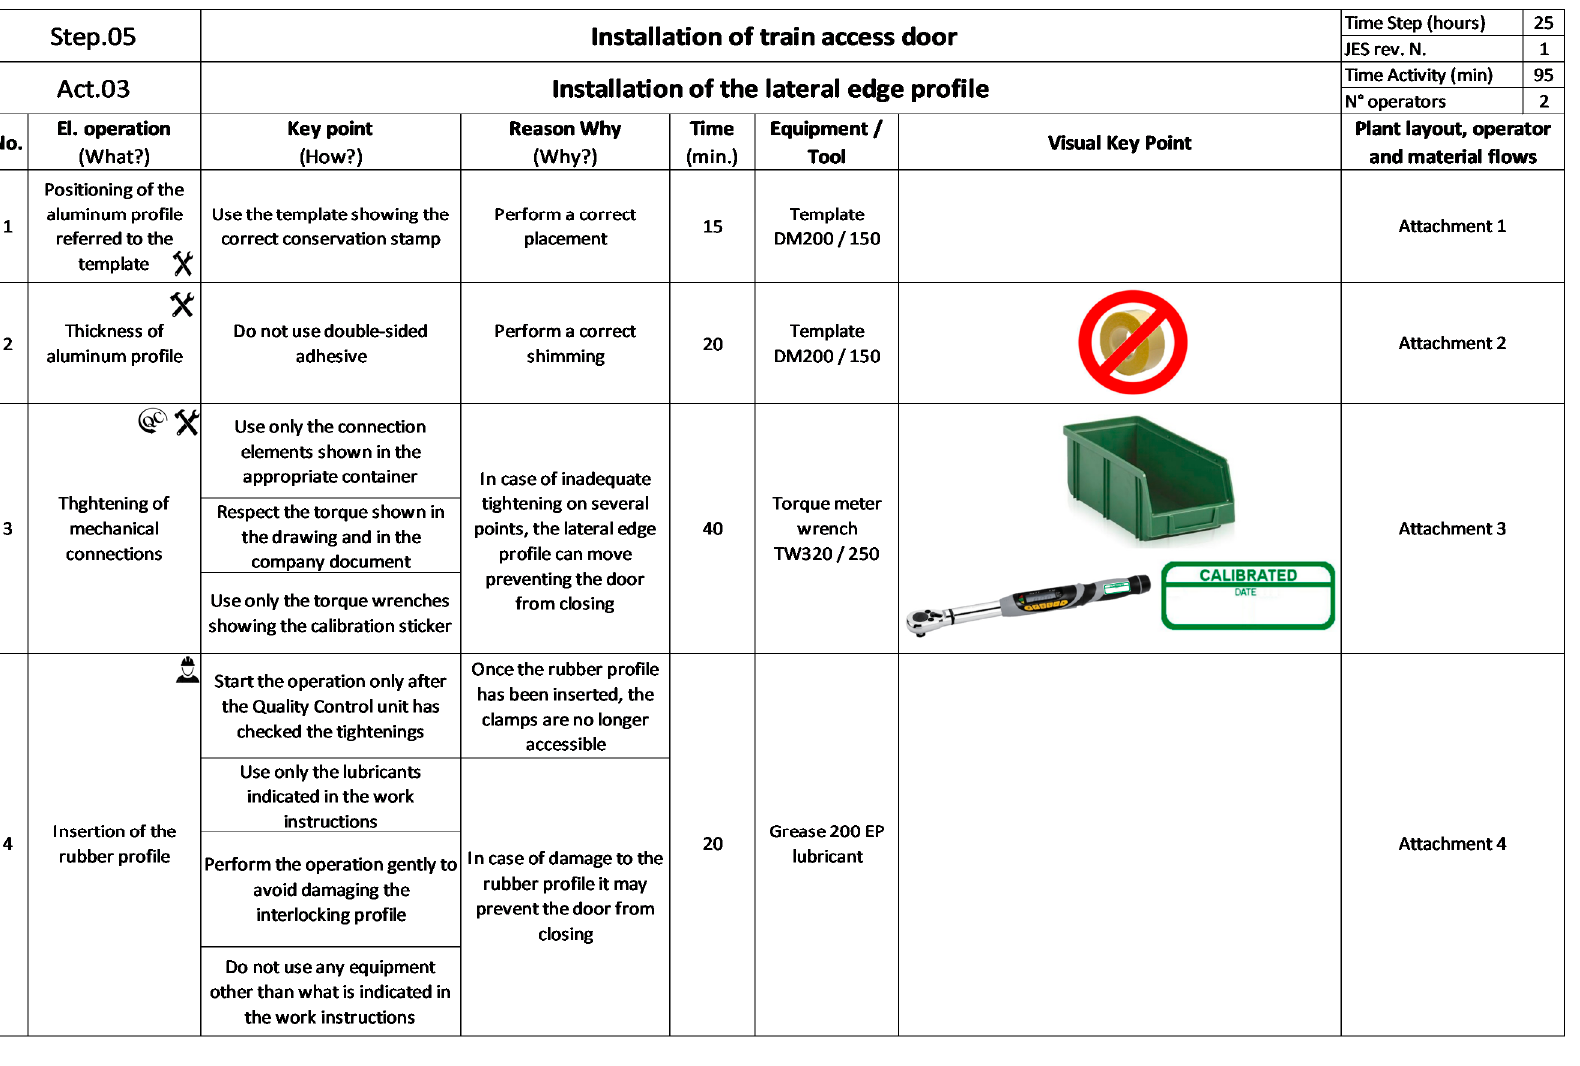
Figure 6. Example of D-JES module related to the installation of the lateral edge profile.